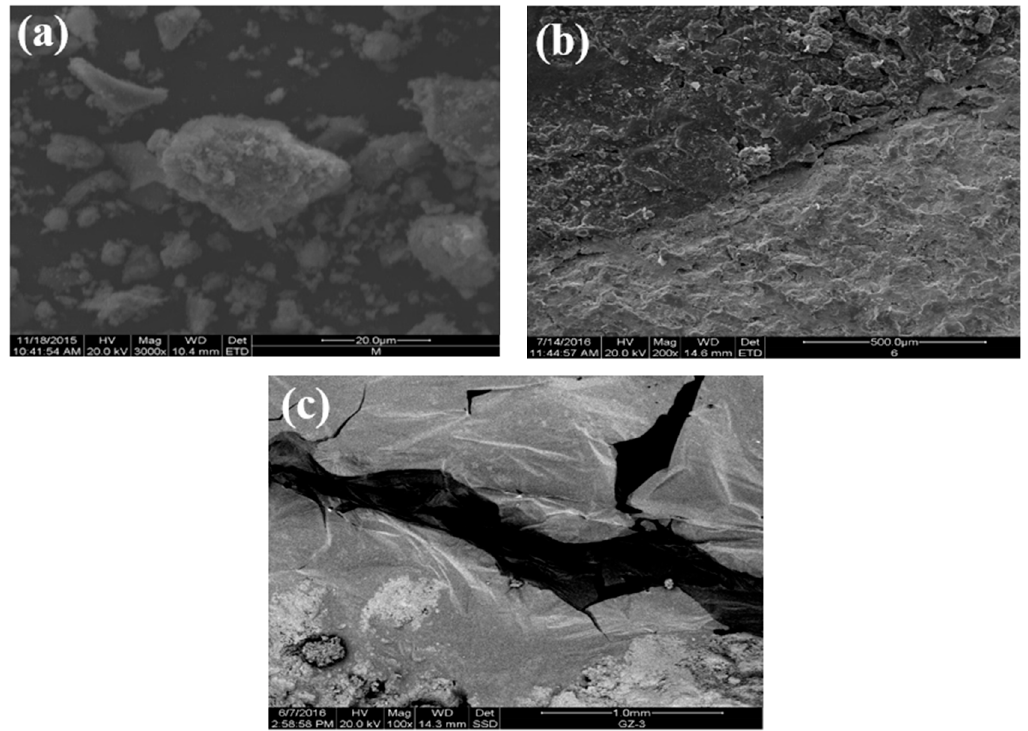
Figure 5. Morphologies: ( a ) SEM of the steel–slag aggregate; ( b ) SEM of the asphalt–steel slag mineral composition mixture; ( c ) SEM of the steel slag–asphalt interface.